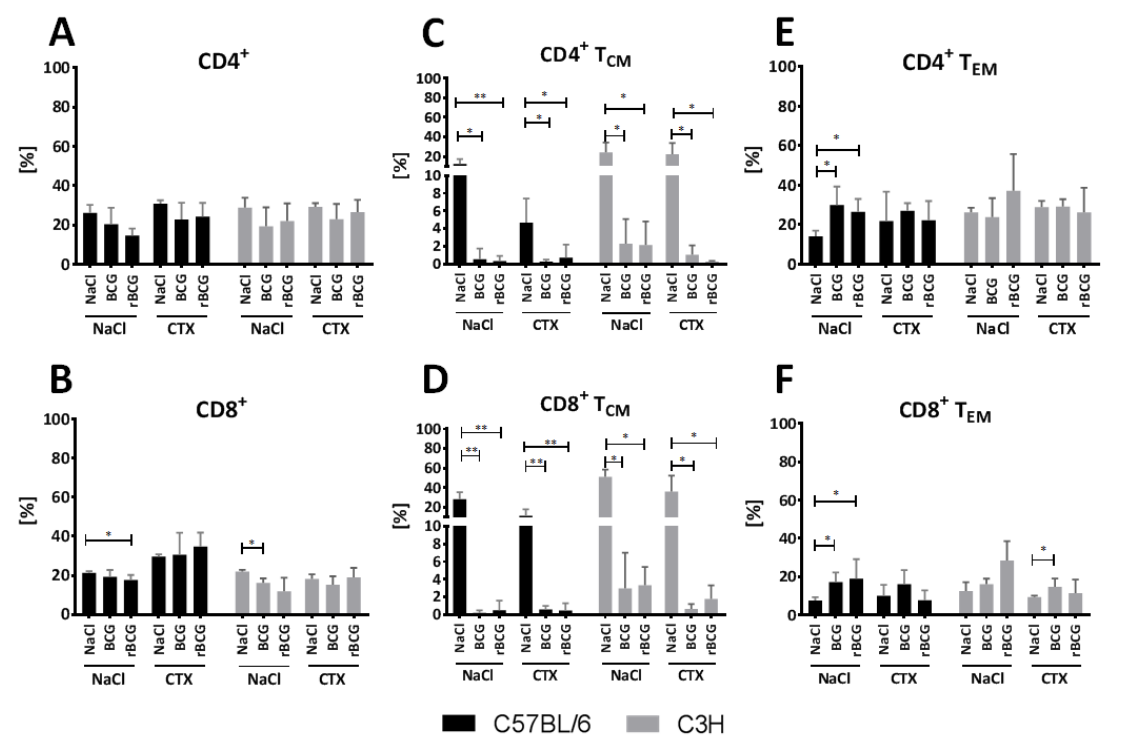
Figure 5. Comparison of central (T CM ) and effector memory T cells (T EM ) in C57BL6 and C3H mice who were non-immunized or immunized with the wild-type BCG or recombinant BCG (rBCG) secreting IL-18 and in mice who were immunocompromised with cyclophosphamide (CTX) or who were immunocompetent (NaCl, Control). Graphs show cumulative data for n = 7 mice/group. Data are expressed as mean ± SD (standard deviation) T CM or T EM percentages; * p value < 0.05, ** p value < 0.01. ( A ) total number of CD4 + T cells, ( B ) total number of CD8 + T cells, ( C ) number of CD4 + T CM cells, ( D ) number of CD8 + T CM cells, ( E ) number of CD4 + T EM cells, ( F ) number of CD8 + T EM cells.